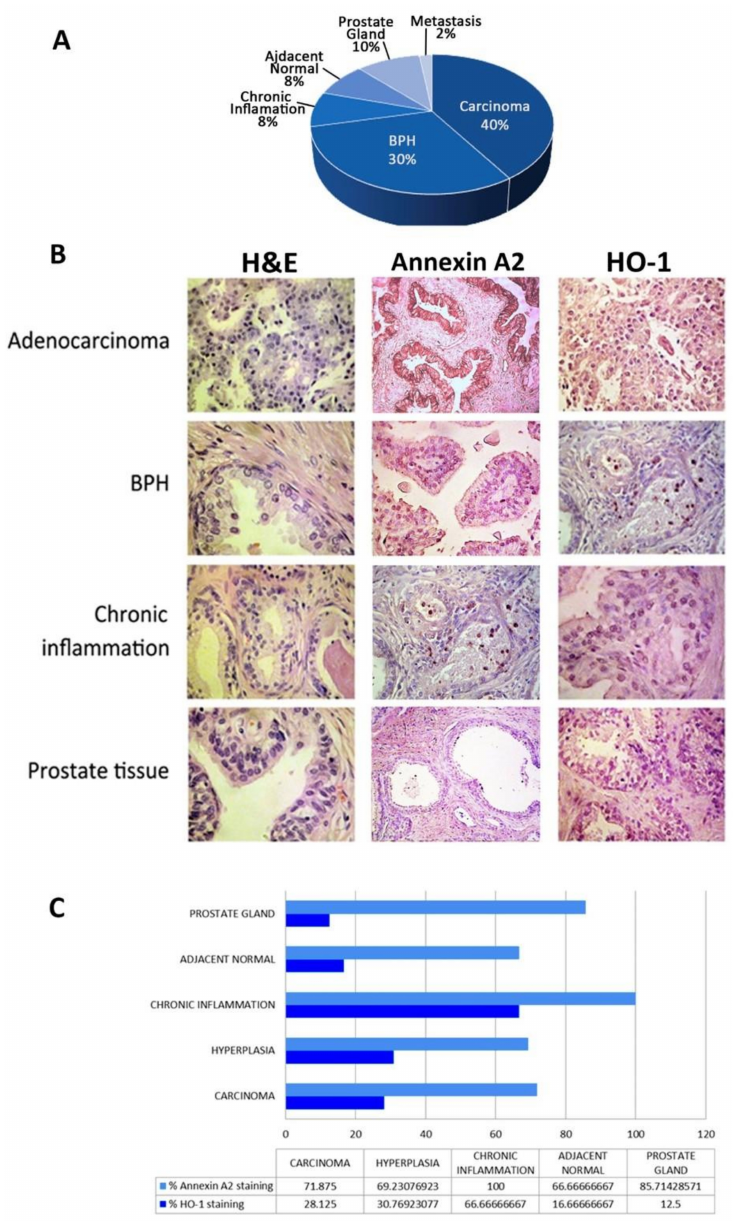
Figure 5. Immunohistochemical (IHC) assessment of HO-1 and ANXA2 in a human tissue micro arrays (TMA). Prostate disease spectrum tissue microarray was used for the IHC analyses, containing 32 cases of adenocarcinoma, two metastasis, 26 hyperplasia, six chronic inflammation, six cancer adjacent prostate tissue, and eight normal tissue. ( A ) Pie chart shows the distribution of the disease stages analyzed in the TMA. ( B ) Representative images for adenocarcinoma, BPH, chronic inflammation, and normal gland stained with H&E or immunoassayed for Annexin 2 or HO-1. ( C ) Graph represents the percentage of positive samples for ANXA2 or HO-1 immunostaining across the di ff erent prostate tissue